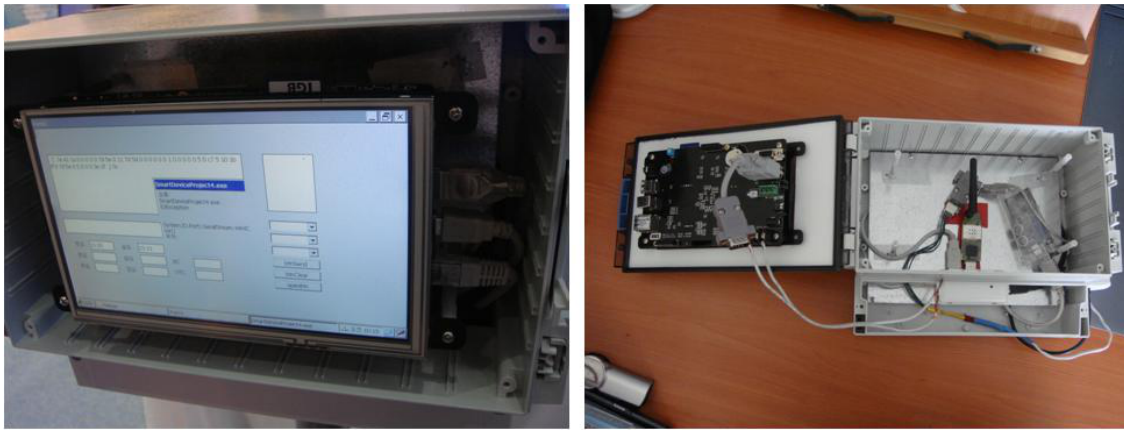
Figure 13. Embedded Board Module (Gateway, Database, and Web Server).